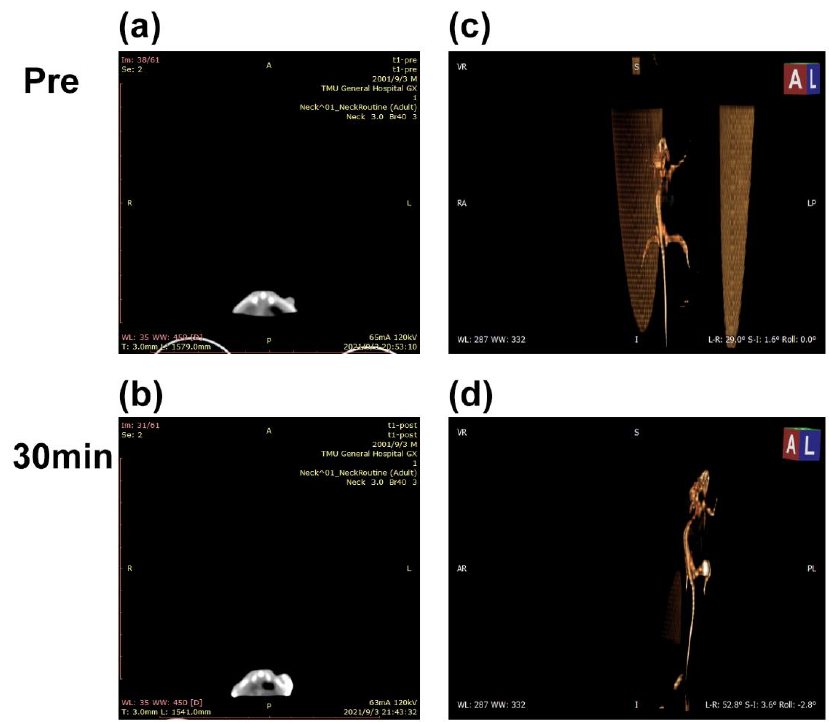
Figure 11. Micro-CT images before ( a ) and after ( b ) intratumor injection of Ag-UCNPs@SiO 2 in Balb/c mice, ( c ) and ( d ) are the 3-D render of ( a ) and ( b ).